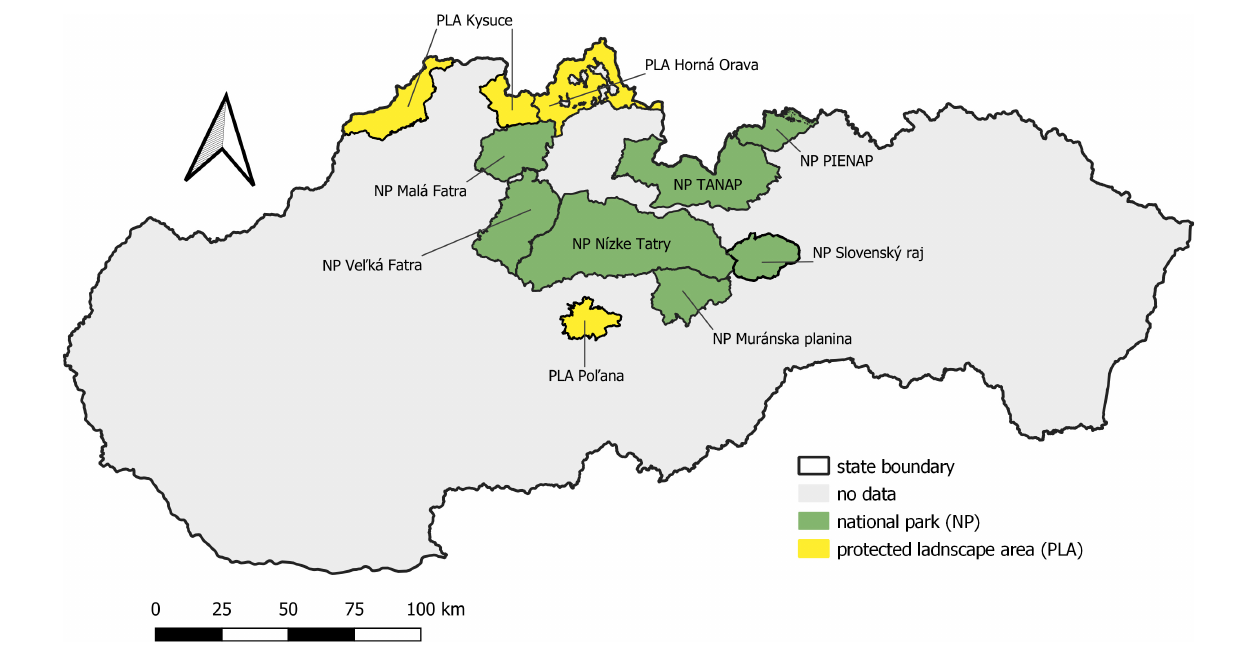
FIGURE 2 | Large-scale protected areas with occurrence of Norway spruce in Slovakia. TABLE 1 | Elevation interval of the study area with the number of phenological stations in individual protected areas. Protected